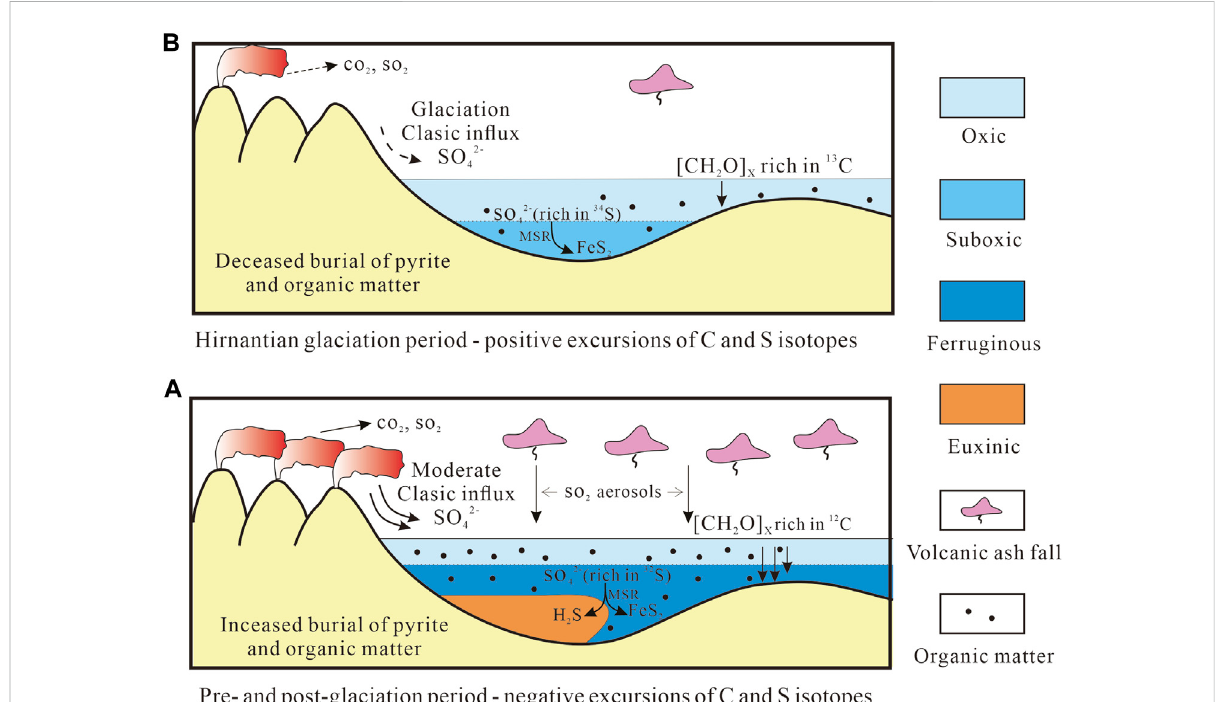
FIGURE 10 SchematicmodelforthecarbonandsulfurcyclesintheUpperYangtzeBasinduringtheO-Speriod. (A) Pre-andpostglaciationforthenegative excursions of δ 13 C org and δ 34 S py , (B) Hirnantian glaciation for the positive excursions of δ 13 C org and δ 34 S py . MSR, microbial sulfate